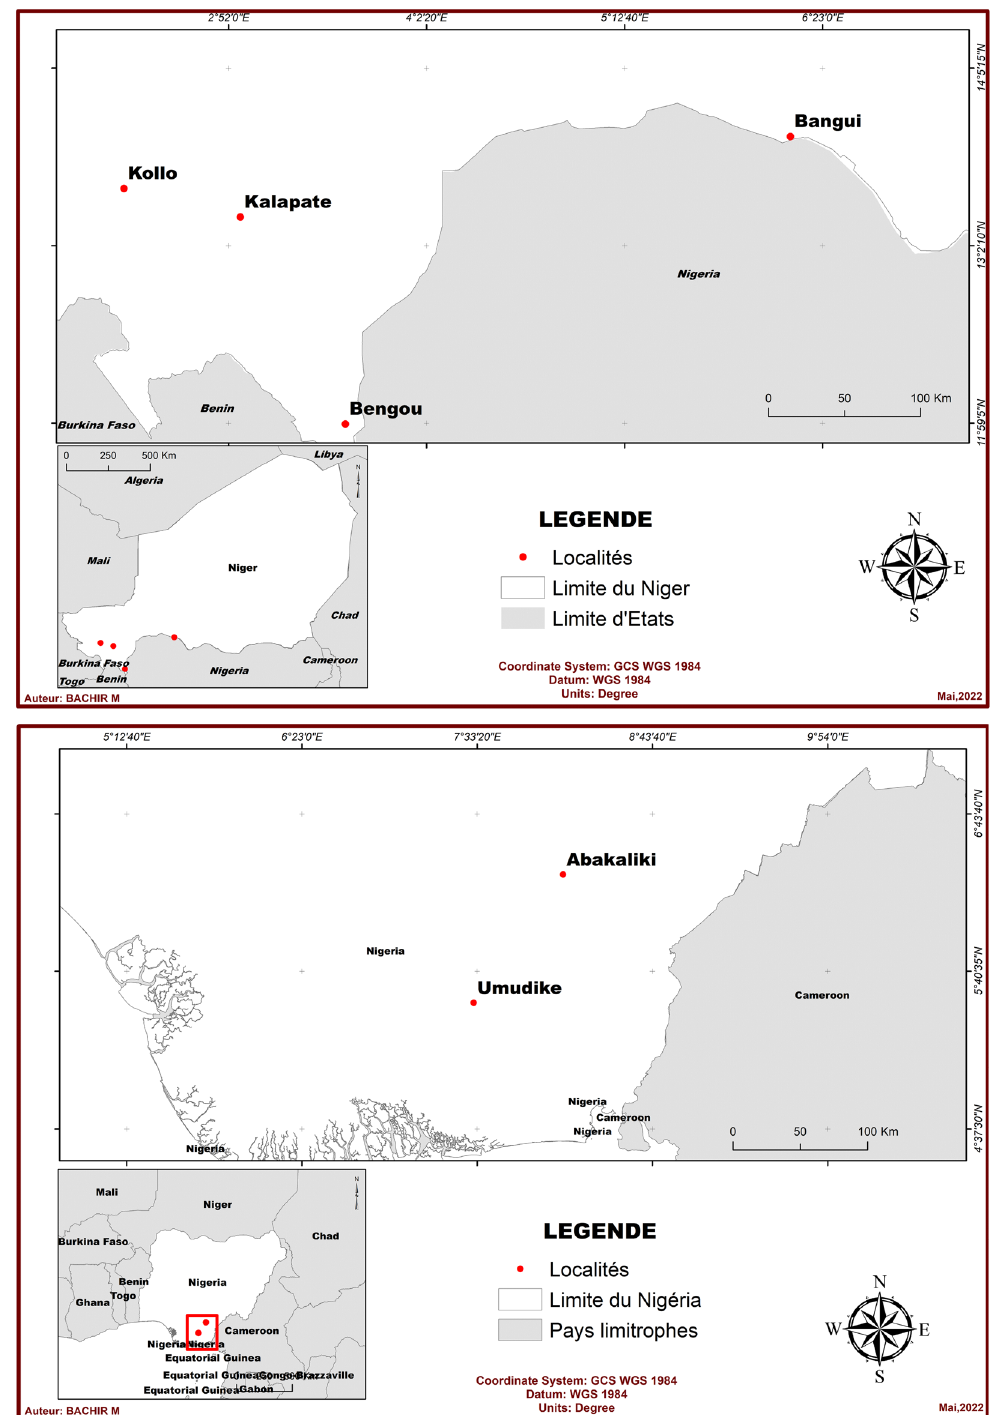
Figure 1. The six locations used for AYT four from Niger (above) and two from Nigeria